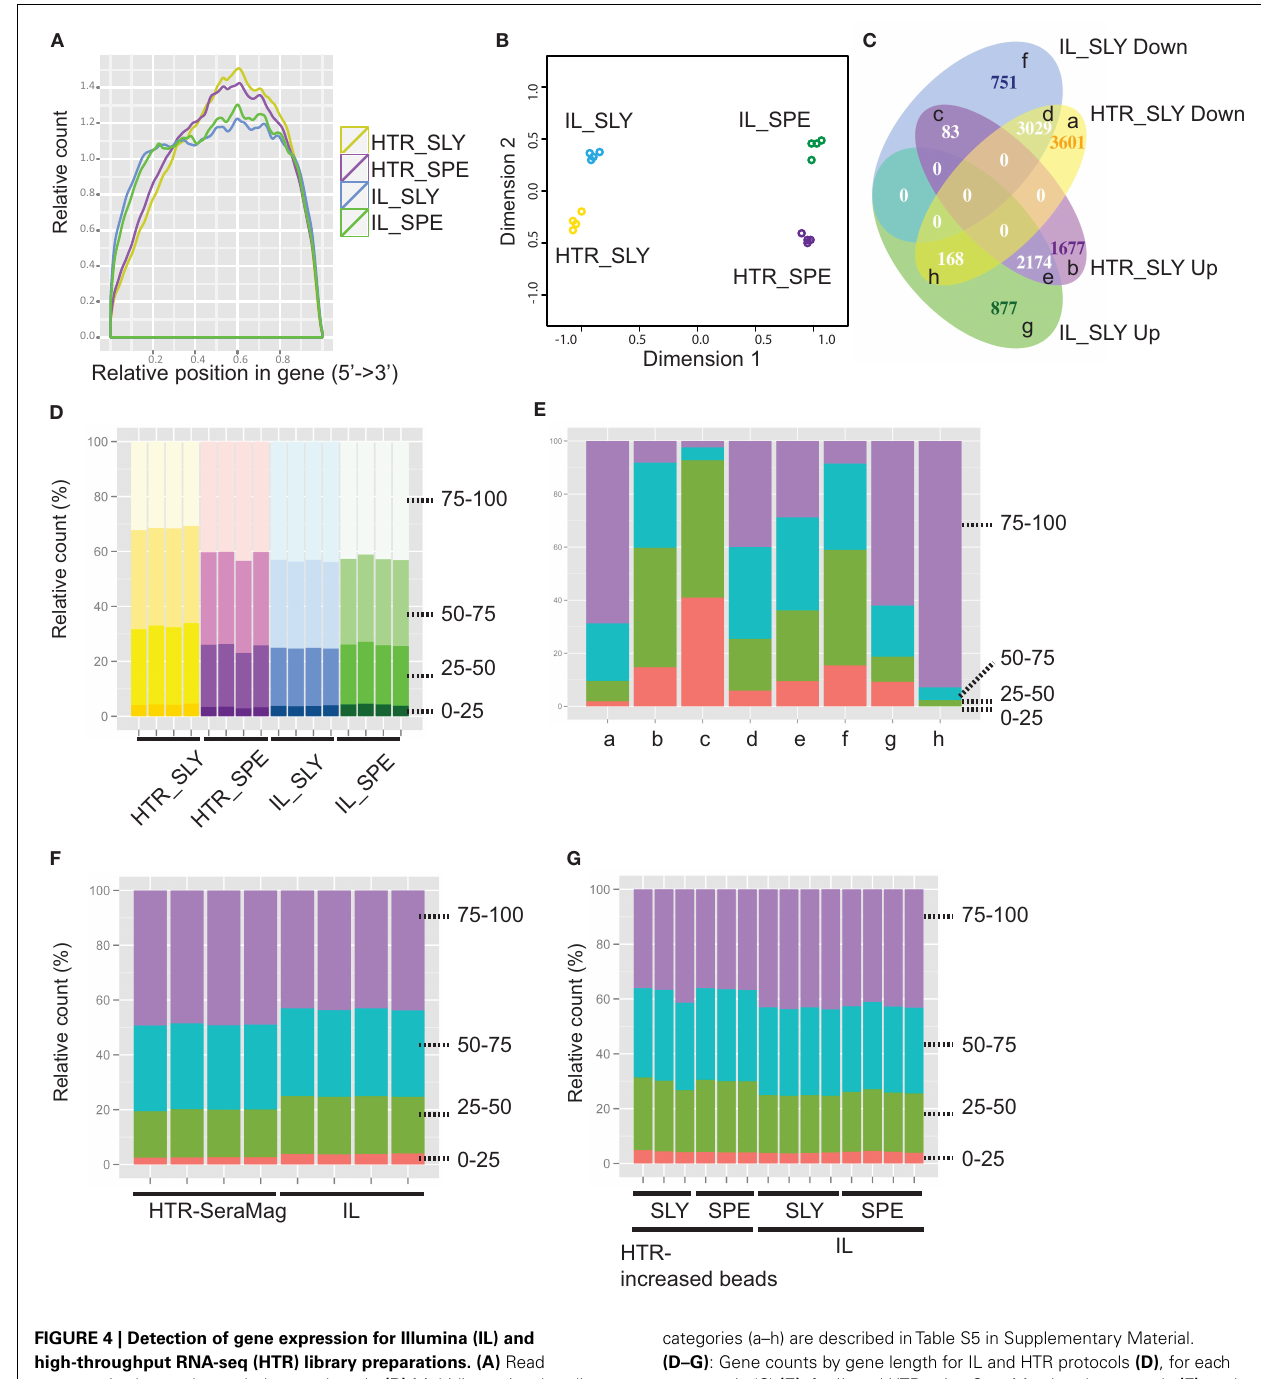
FIGURE 4 | Detection of gene expression for Illumina (IL) and high-throughput RNA-seq (HTR) library preparations. (A) Read coverage is shown along whole gene length. (B) Multidimensional scaling (MDS) plot for assessing the variations amongst samples. Graph was made using the edgeR package in R. (C) VennDiagram comparing IL and HTR protocols for differential expressed genes (BH adjusted p -value < 0.01) between S. lycopersicum (SLY) and S. pennellii (SPE).The using ggplot2.